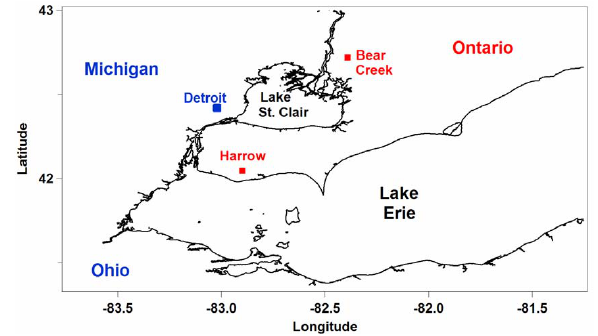
Figure 1. Harrow, ON and the surrounding area Fig. 1. Harrow, ON and the surrounding